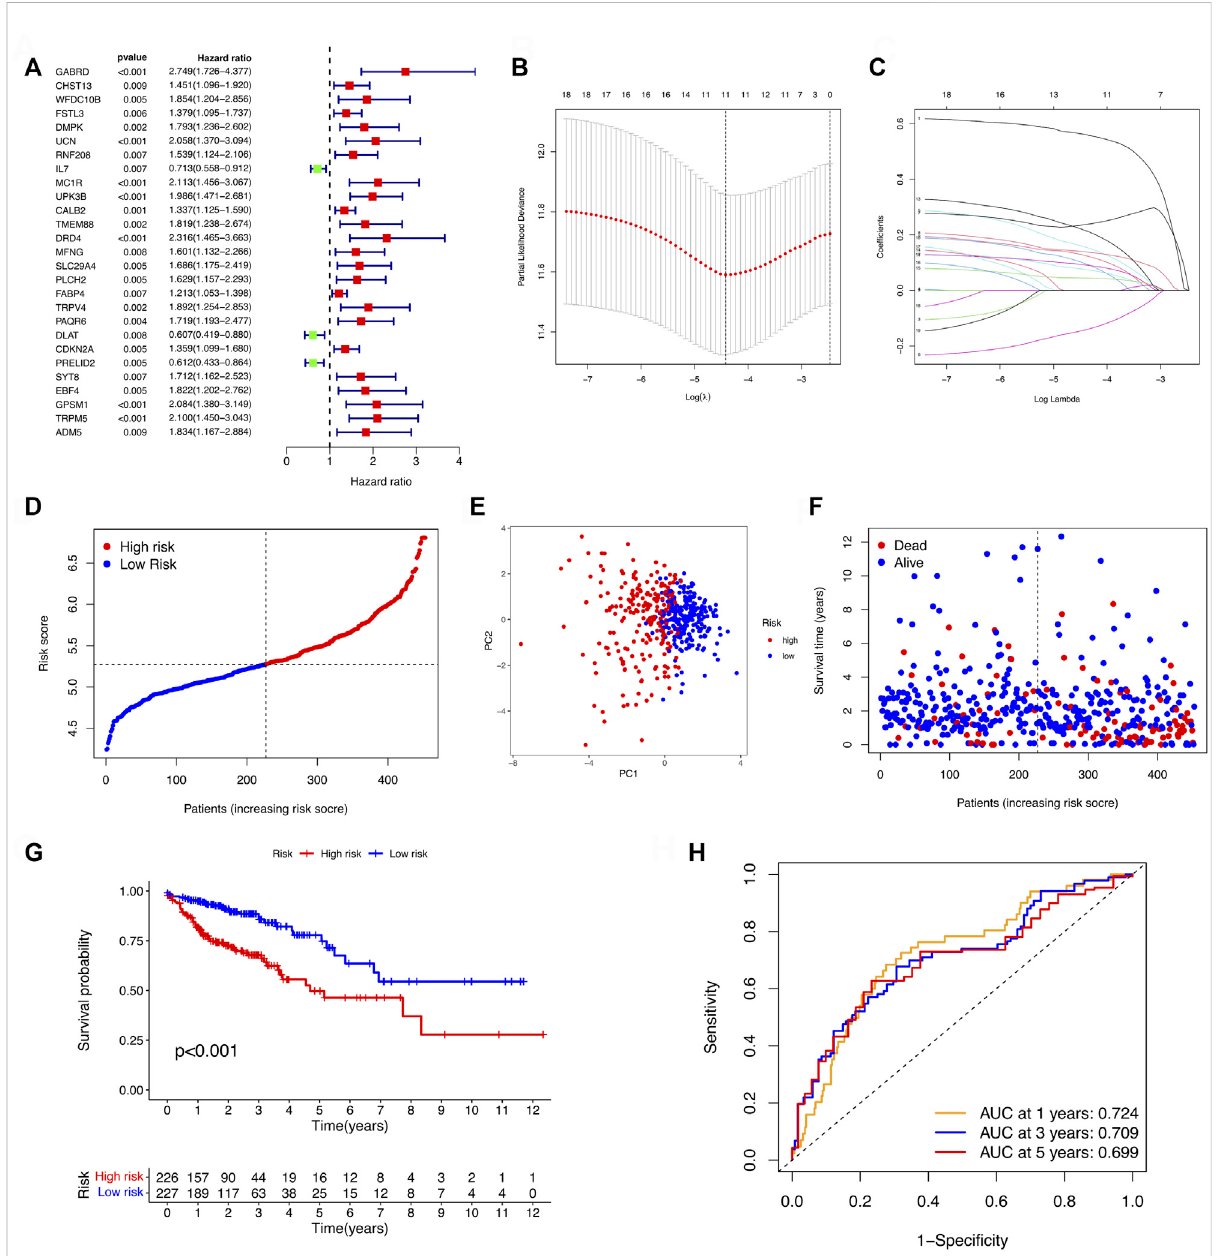
FIGURE 3 Establishmentofthecuproptosis-relatedsignature. (A) ForestplotsrevealingtheunivariateCoxregressionanalysisresultfortheOSoftheDEGs between the two clusters. (B) Cross-validation for the optimal parameter and operator model selection in the LASSO regression. (C) LASSO regressionof the 27 prognosis-related genes. (D) Distribution of patients based on the risk score. (E) PCA plot for COAD upon the basis of risk score. (F) Survival status of COAD patients. (G) KM curves for the OS of patients in the two risk groups. (H) ROC curves manifested the prognostic performance of the risk score in the COAD cohort. AUC: Area under the